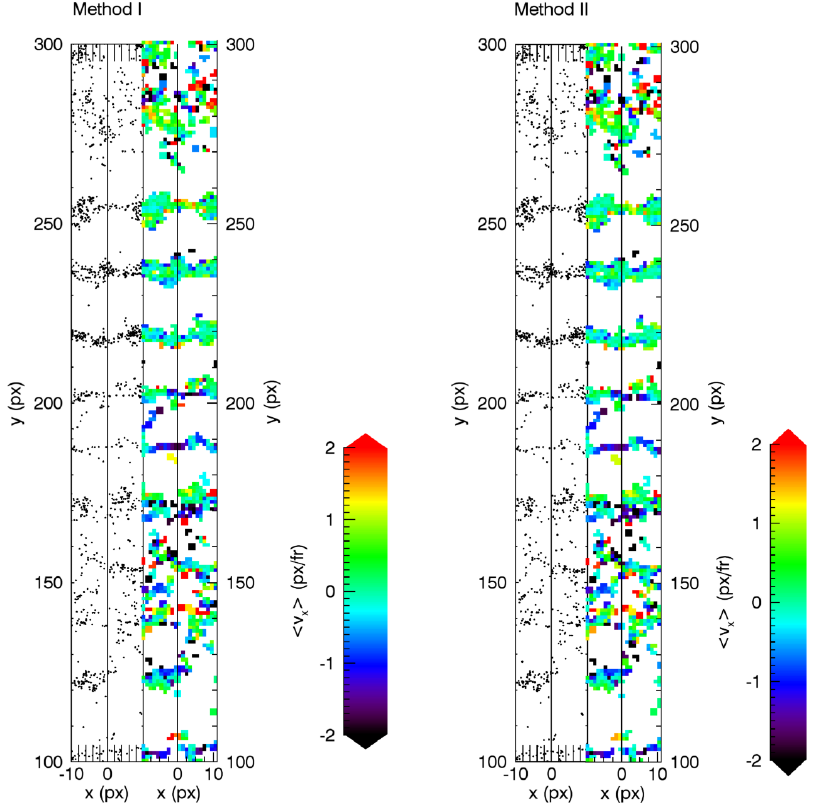
Figure 6. Tracks and average velocities of particles crossing the point (in this plot x = 0) where the original left image (Camera 1) was joined to the transformed right image (Camera 2). Even though differences are visible in the positions between the two methods, neither method results in an obvious jump at x =